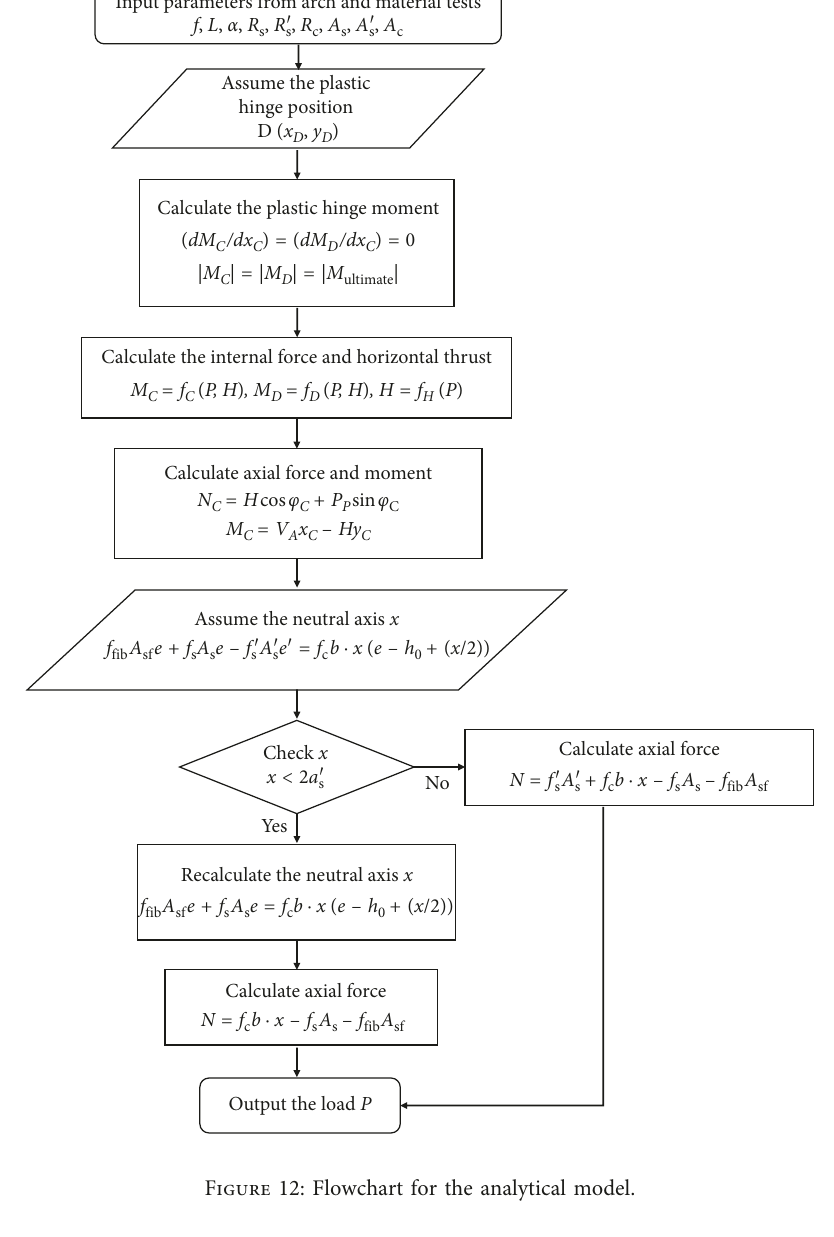
Figure 12: Flowchart for the analytical